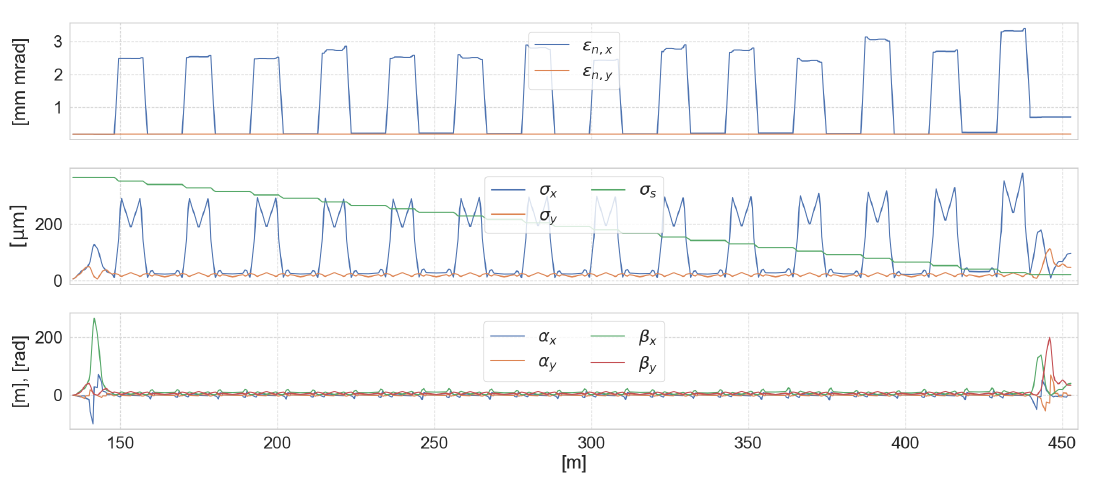
Figure 3. Main parameters of the bunch in simulations of the two passes trough the matching line and the arc compressor in presence of LSC and CSR effects. Top: transverse normalized total beam emittances. Middle: longitudinal and transverse beam envelopes. Bottom: main Twiss parameters.